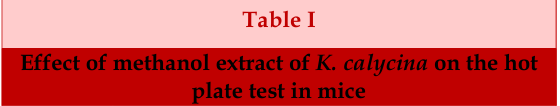
Effect of methanol extract of K. calycina on the hot plate test in mice